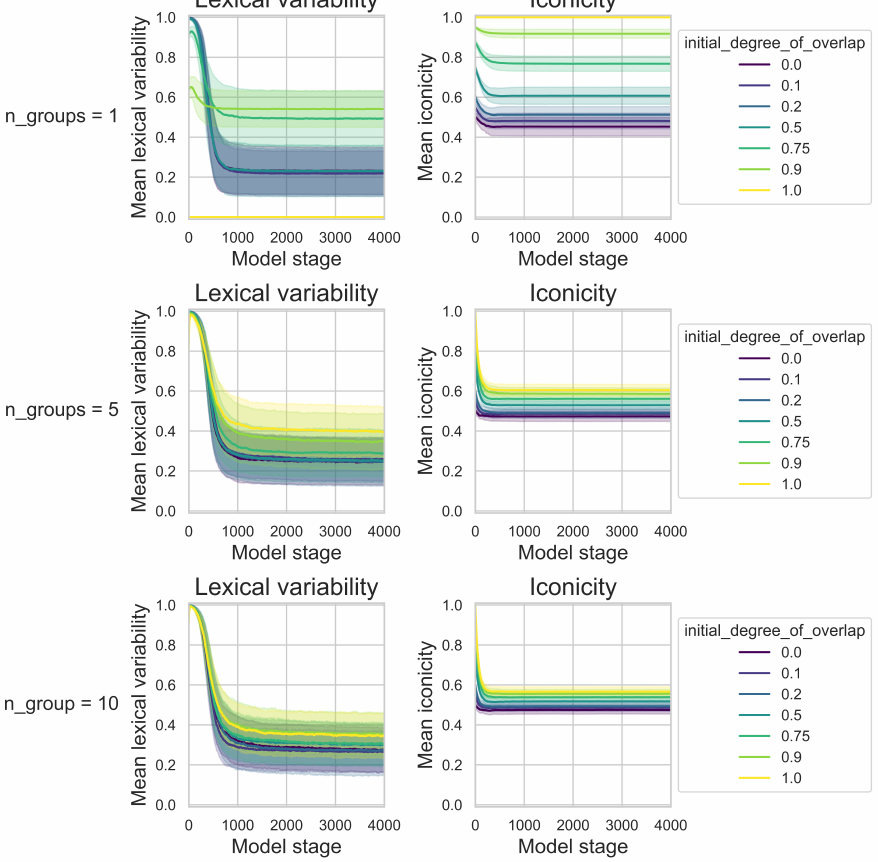
Figure A1. The mean lexical variability over the 2000 model stages for different numbers of groups that agents can be assigned to ( n_groups ): 1, 5 and 10, while varying the degree of overlap between the form and culturally salient features at the start of the run ( initial_degree_of_overlap ). The dark line represents the mean and the shaded area represents the standard deviation of the 100 repetitions. With one exception ( n_groups = 1 and initial_degree_of_overlap = 1), the higher the initial degree of overlap between form and culturally salient features, the lower the mean lexical variability. In addition, the higher the initial overlap between form and culturally salient features, the higher the degree of